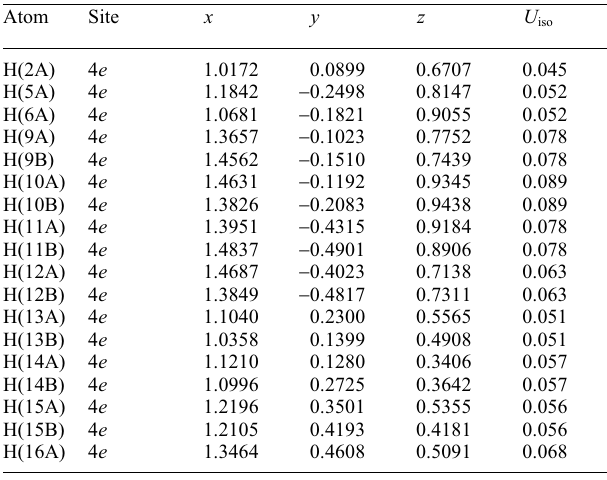
Table 2. Atomic coordinates and displacement parameters (in Å 2 )